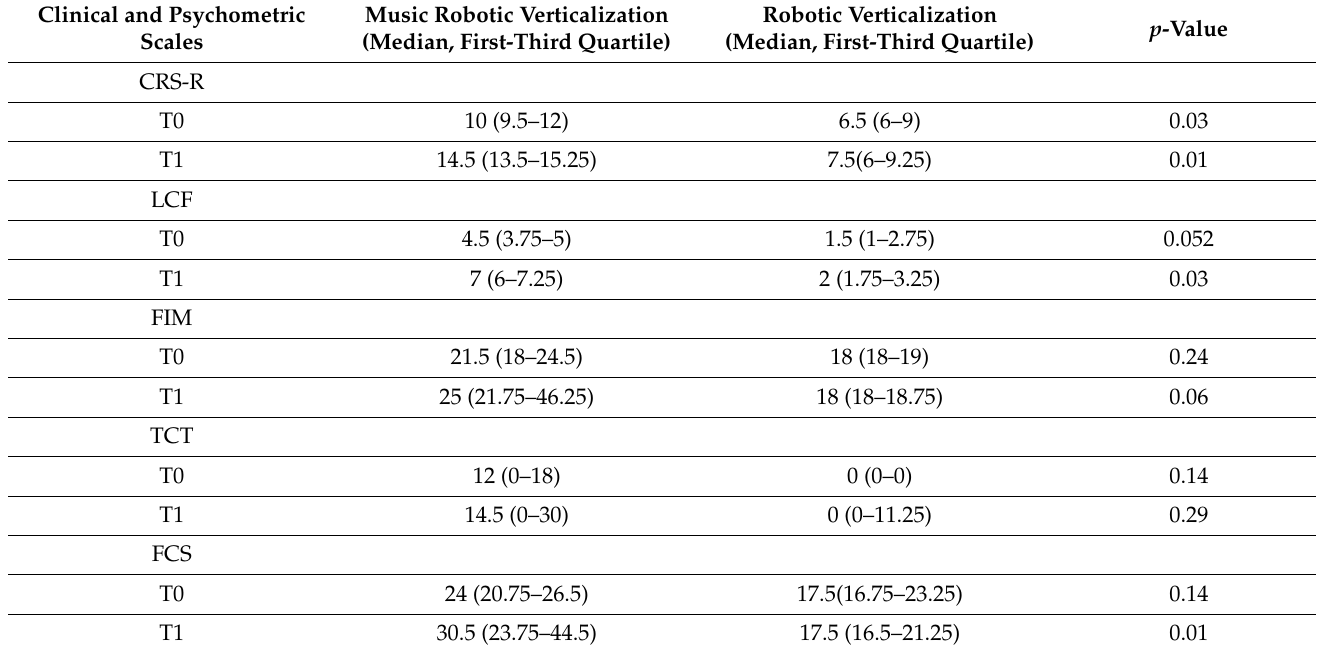
Table 3. Statistical comparison of the clinical score variations from baseline to follow-up between experimental group (music robotic verticalization) and control group (robotic verticalization); scores are in median (first–third